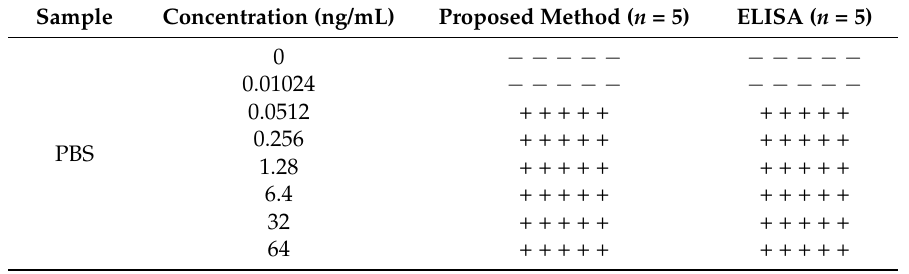
Figure 5. Sensitivity and specificity testing of the handheld inkjet printing paper chip based smart tetracycline detector. ( A ) Sensitivity testing based on detecting different concentrations of tetracycline using the proposed smart tetracycline detector. ( B ) Specificity testing based on detecting different antibiotics using the proposed smart tetracycline detector. The numbers on the columns represent standard deviations computed from 5 measurements. The dotted line in ( A ) indicates the signal at the detection limit. Table 1. Detection on tetracycline in PBS using the proposed method and commercial ELISA